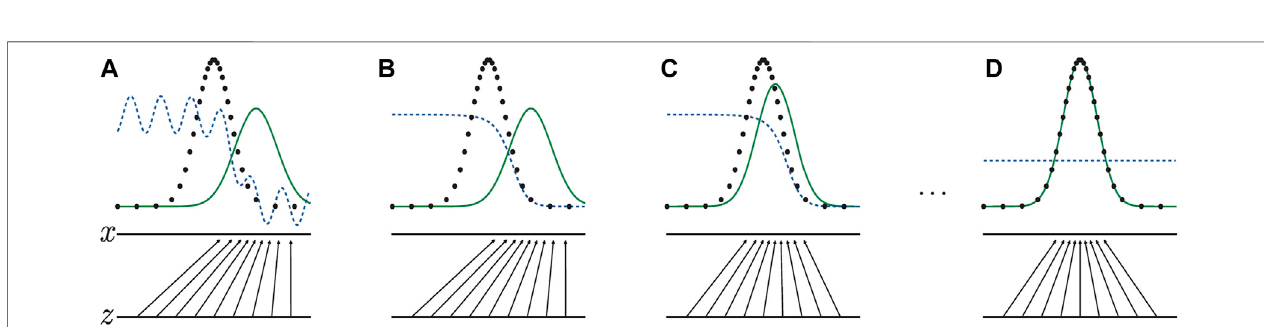
FIGURE4| ThebasicGANtrainingprocess,whichisreprintedwithpermissionfromGoodfellowetal.(2014). (A) ThebeginningoftrainingGANs; (B,C) Thetraining is in progress; (D) The end of training.